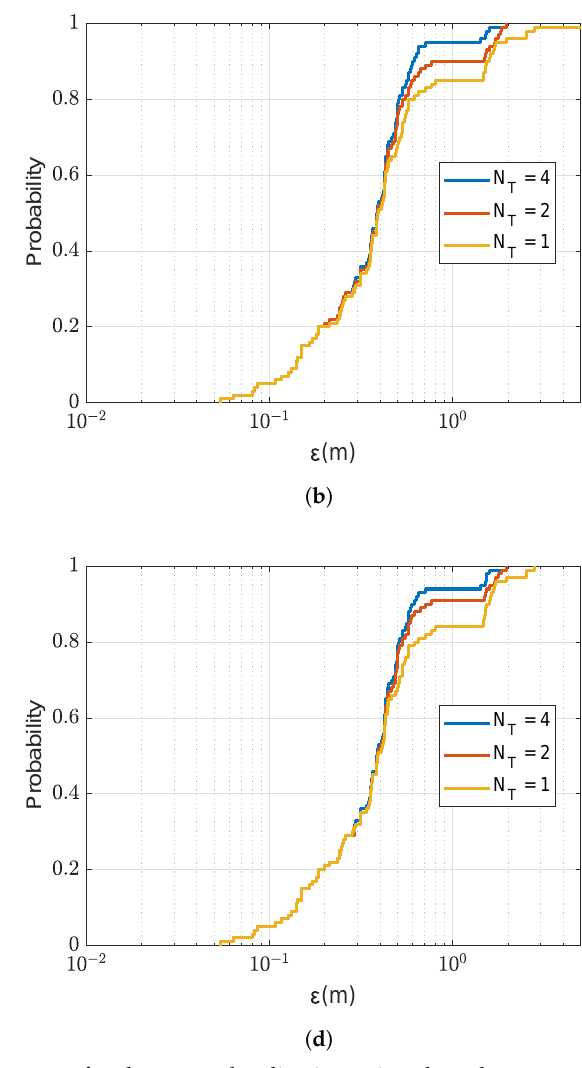
Figure 9. CDF of the localization error ε for the coarse localization using the coherent and non- coherent AFs at low and high carrier frequency f c against the number of transmit antennas N T ; the SSP is uniform as shown in Figure 3. ( a ) Coherent AF, f c = 3072 Hz. ( b ) Non-coherent AF, f c = 3072 Hz. ( c ) Coherent AF, f c = 15,360 Hz. ( d ) Non-coherent AF, f c = 15,360